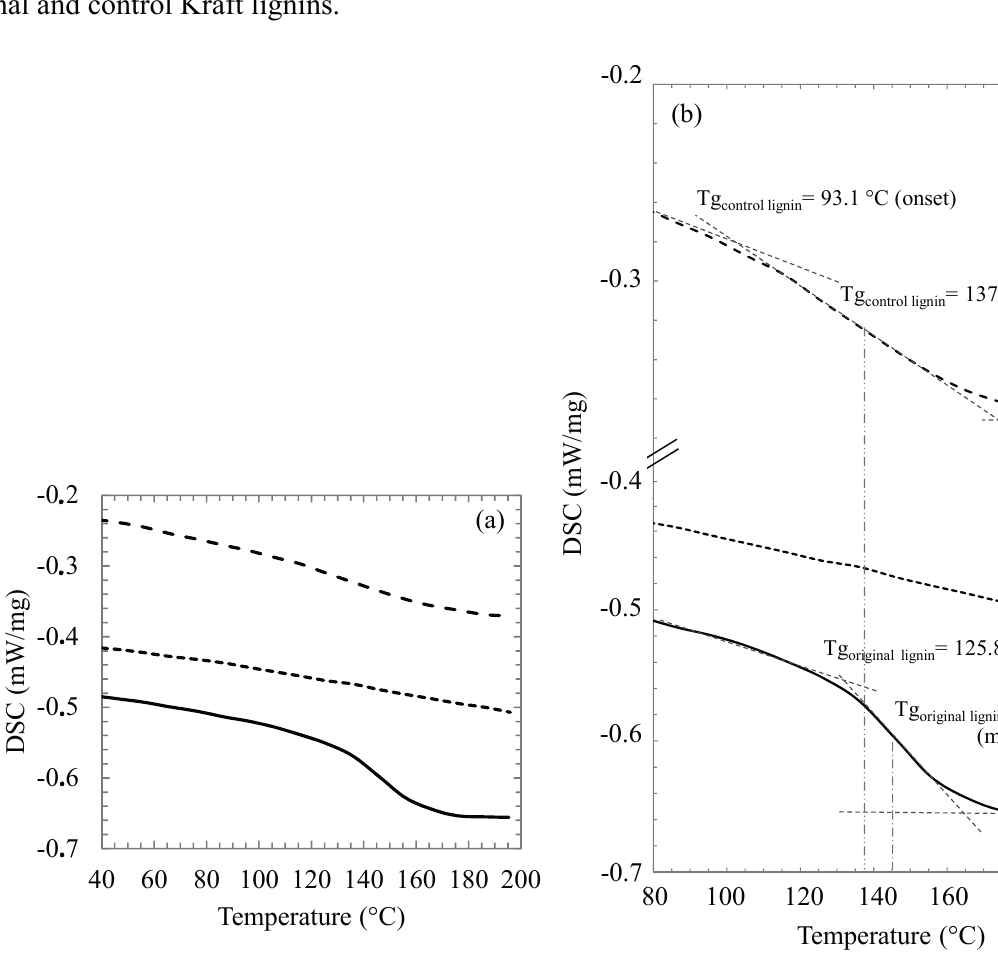
Figure 6. ( a ) Differential Scanning Calorimetry (DSC) thermograms of original Kraft lignin (continuous line); control Kraft lignin extracted from the [C 4 C 1 im][OTf]/[C 4 C 1 im][PF 6 ] binary system without enzyme (large dotted line) and lignin oleate extracted from the [C 4 C 1 im][OTf]/[C 4 C 1 im][PF 6 ] binary system after transesterification catalyzed by the immobilized lipase B from Candida antarctica (small dotted line) and ( b ) their respective zoomed